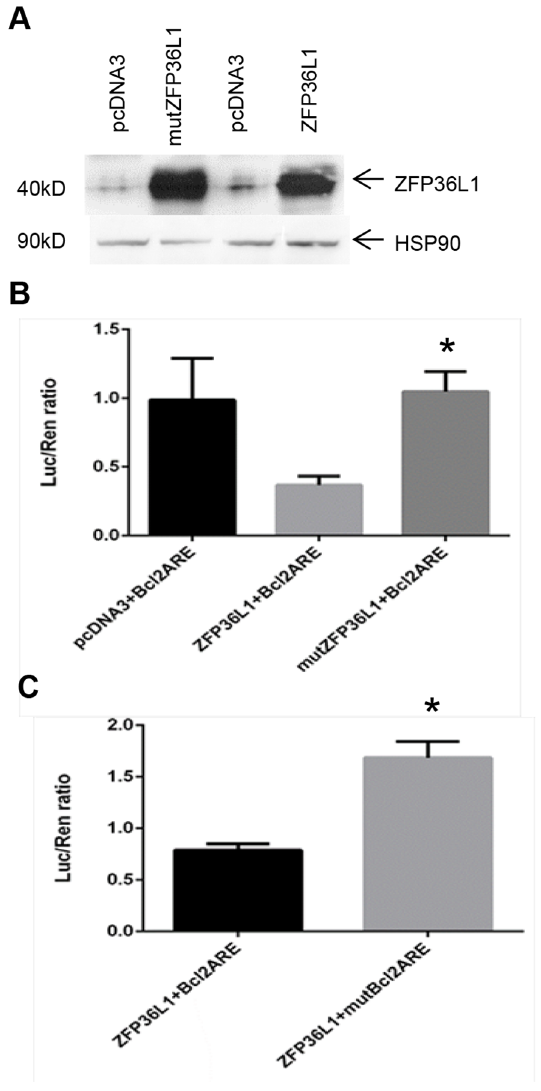
Figure 5. ZFP36L1 mediates degradation of a 3 9 UTR BCL2 ARE. (A) Transfection of ZFP36L1 or mutant ZFP36L1 into HEK293T cells results in high level ZFP36L1 expression as shown by Western blot analysis. Very low/absent levels of ZFP36L1 are found in empty vector (pcDNA3) transfected HEK293T cells. (B) ZFP36L1 interacts with the BCL2 ARE and mediates BCL2 ARE degradation. BCL2 3 9 UTR luciferase reporter assay showing reduced luciferase values in HEK293T cells transfected with ZFP36L1 and BCL2 ARE compared to values obtained by co-transfection of BCL2 ARE with either an empty vector (pcDNA3) or a zinc finger mutant ZFP36L1. The results show mean 6 SEM for three independent experiments. p , 0.05 as determined by student T test. (C) BCL2 3 9 UTR Luciferase reporter assay showing that ZFP36L1 requires the BCL2 ARE core AU-rich element to effectively reduce luciferase levels, whereas a BCl2 ARE construct with the core AU-rich element removed is much less affected. The results show mean 6 SEM for three independent experiments, p , 0.05 as determined by student T